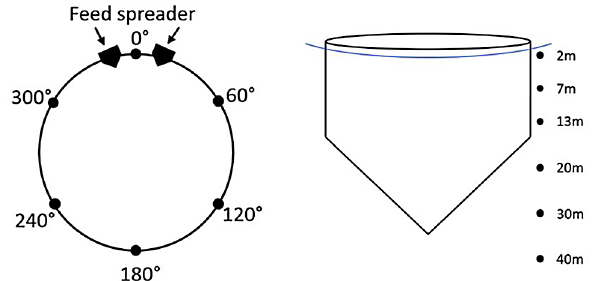
Fig. 4. The 6 positions around a cage (left) and 6 depths (right) where video filming of wild fish was conducted (total: 36